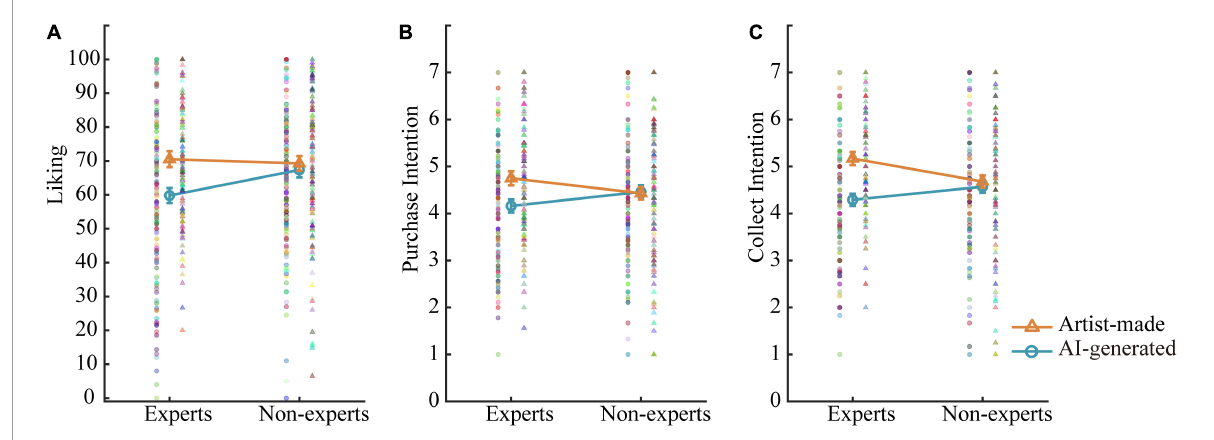
FIGURE2 Author (AI and artist) by art expertise (experts and non-experts) interaction. Consistent results were found for liking rating (A) , purchase intention (B) , and collection intention (C) . Error bars stand for ± S.E.M.